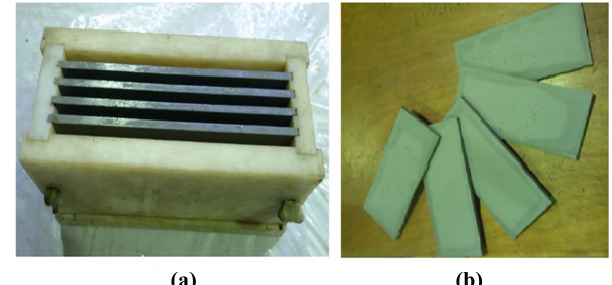
Fig. 3. The mold used for preparing composite samples